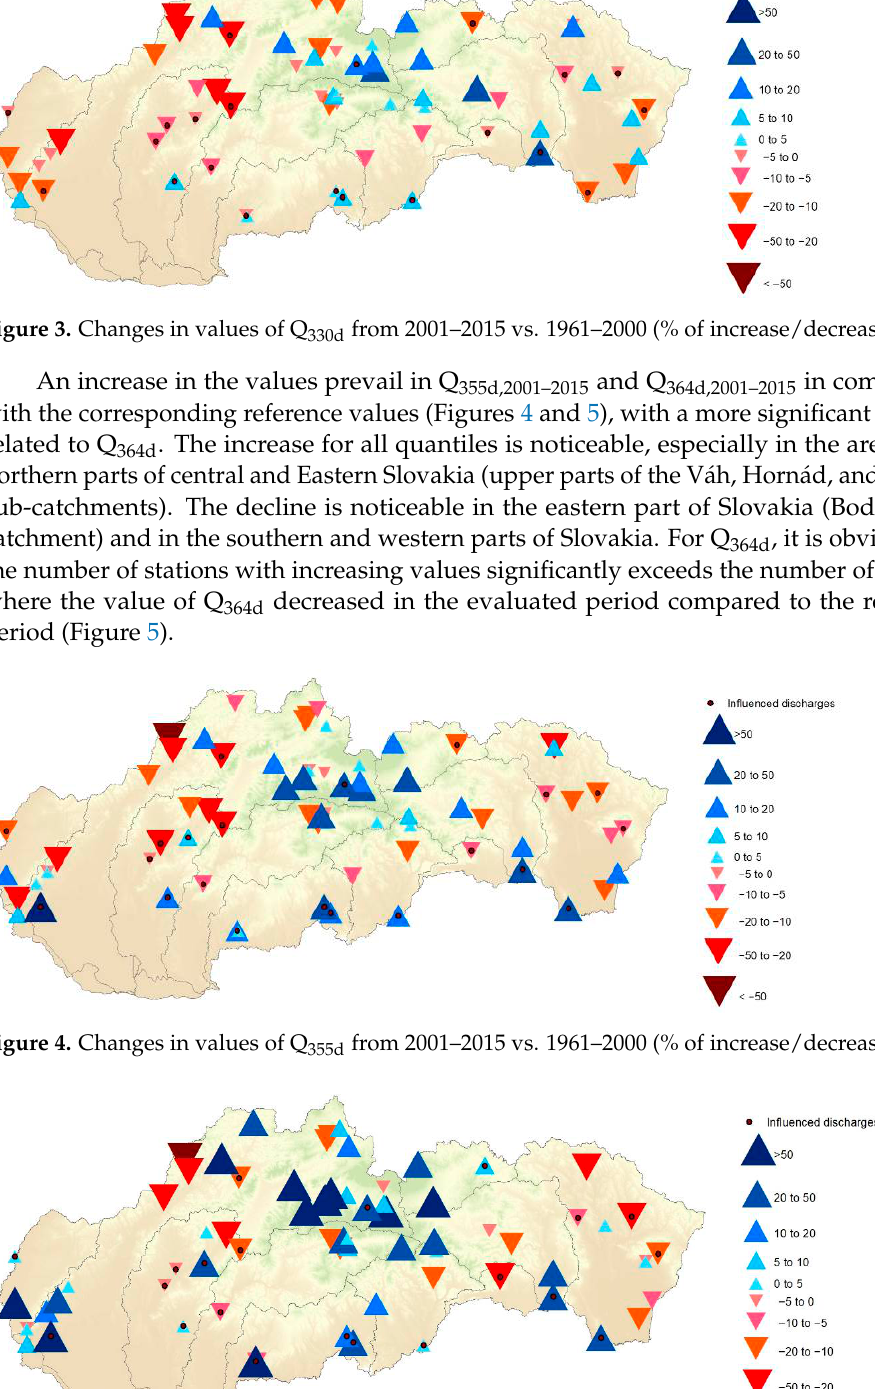
Q Md,rr in the 2001–2015 period compared to the 1961–2000 reference period prevails for all quantiles. For the Q 364d quantile, the increases in the evaluated period are more significant for the standard method than for Method 2 (Figure 6). Figure 6. Changes in values of Q 364d,rr from 2001–2015 vs. 1961–2000 (% of increase/decrease). The increase in the values for all quantiles for the representative stations in compar- ison with the reference period is manifested mainly in the east of Slovakia, in the Hornád, Slaná and, Poprad sub-catchments. The decrease in the values of Q 330d,2001–2015,rr compared to Q 330d,1961–2000,rr is most numerous in the Morava and Váh sub-catchments. 3.3. Non-Flow Characteristics In this study, we assessed the non-flow characteristics based on the number of days with a mean daily discharge below the specified limits. We set the following Q Md values as the limits: Q 270d , Q 330d , Q 355d , and Q 364d , calculated using both methods mentioned above. The limits were set for the 1961–2000 reference period. We analyzed the number of days of low-flow episodes in the 1961–2015 period, as well as the change in the occurrence be- tween the 2001–2015 period and the 1961–2000 reference period. The total number of days with mean daily discharge under individual limits varied in relatively wide ranges (Table 2), while the differences also occurred at WSs within one sub-catchment.